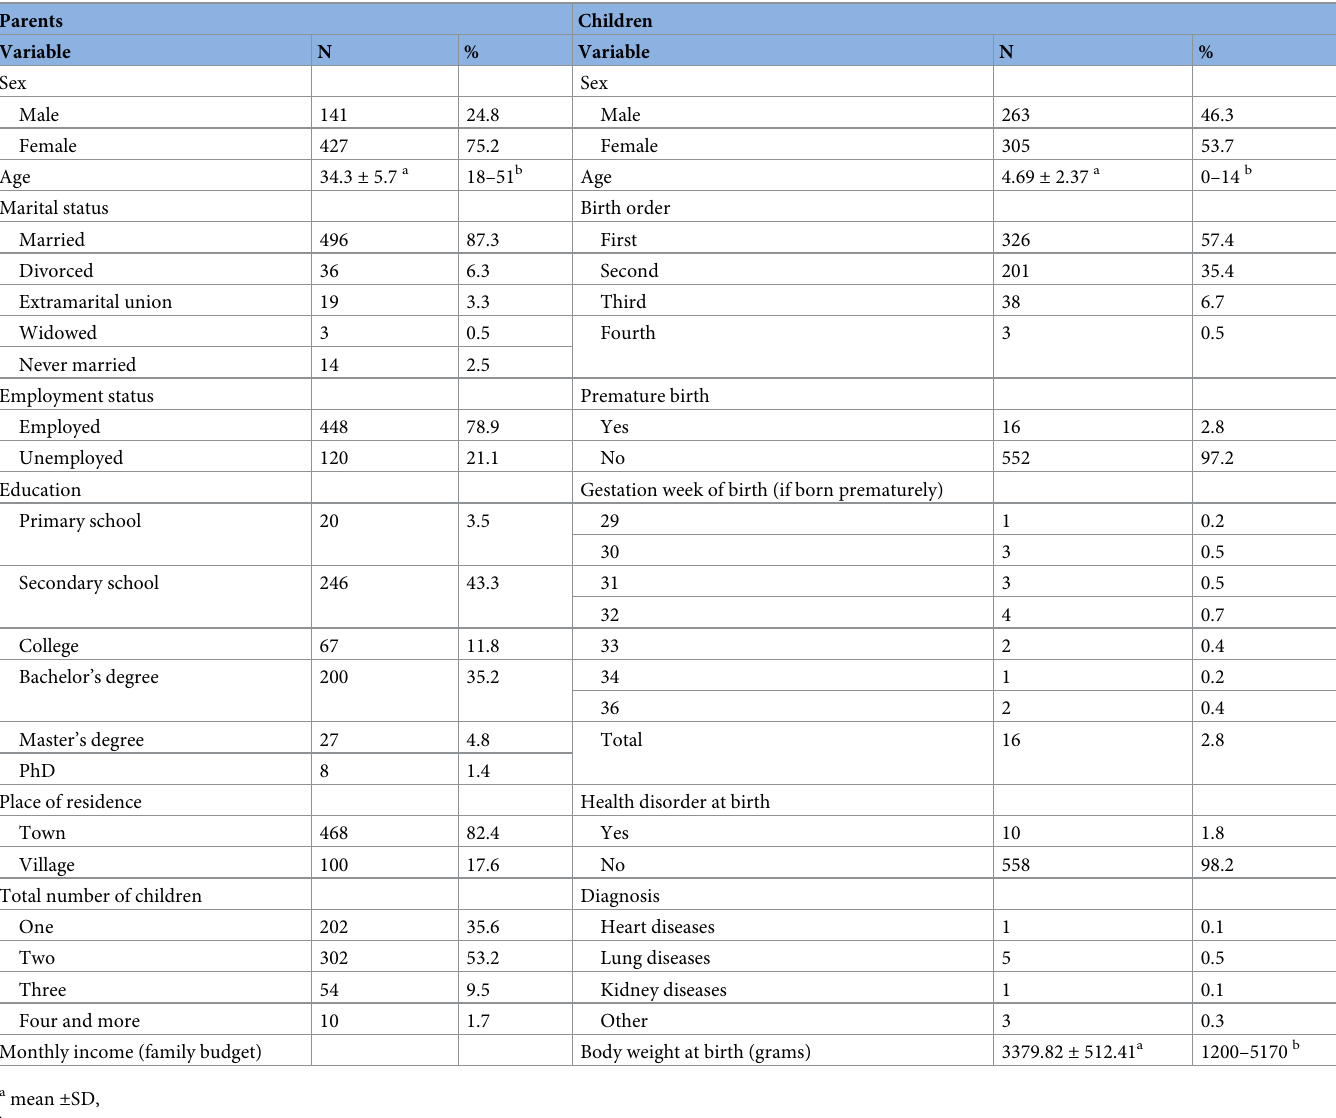
Table 1. Demographic and clinical characteristics of study